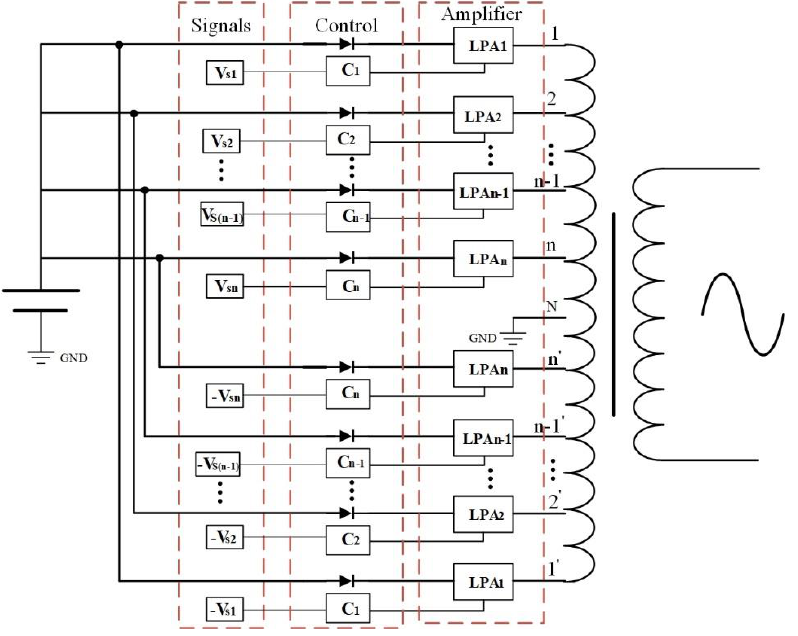
Figure 6. Circuit topology of HDCPLN.